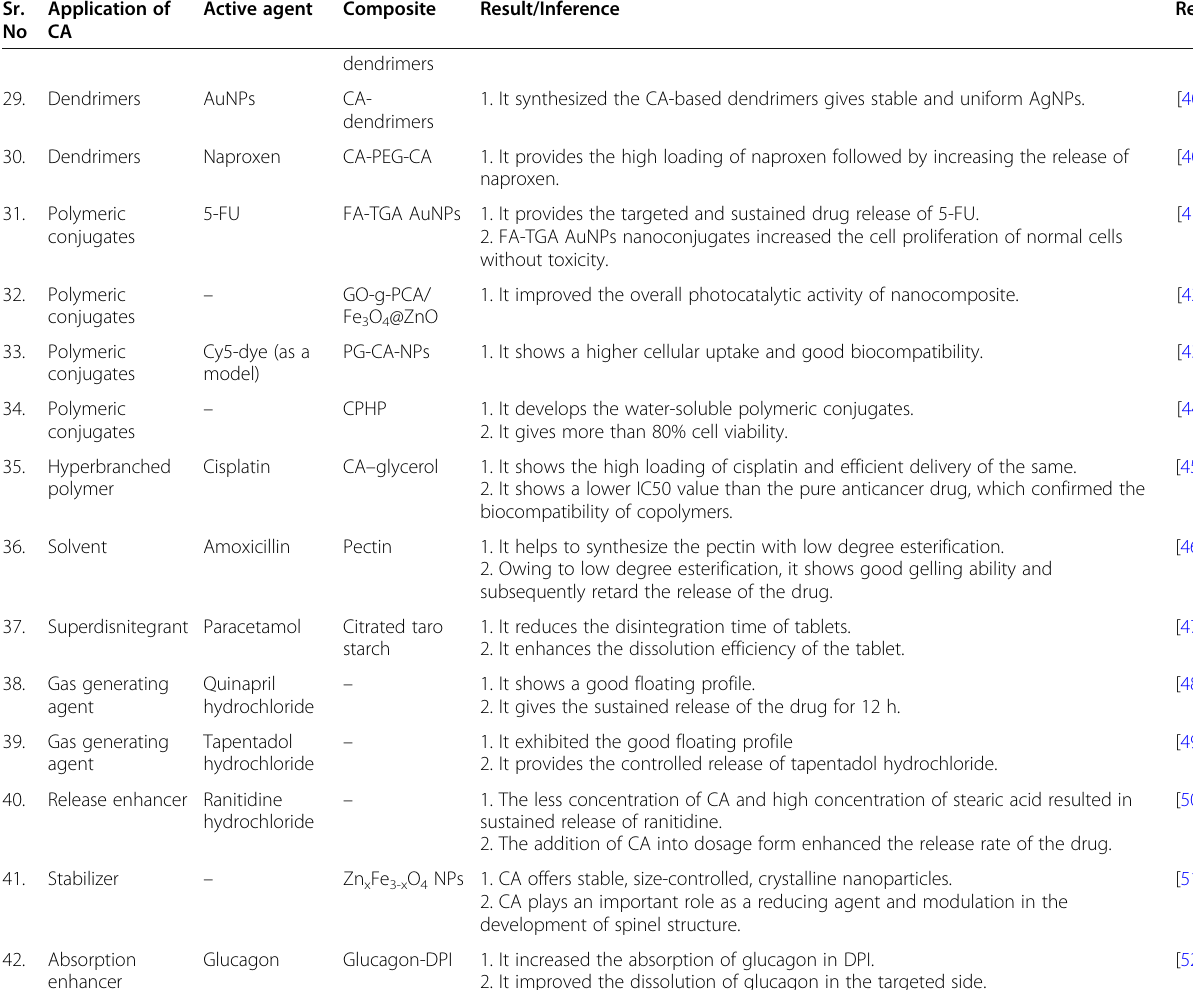
Table 1 Summary of pharmaceutical applications of CA